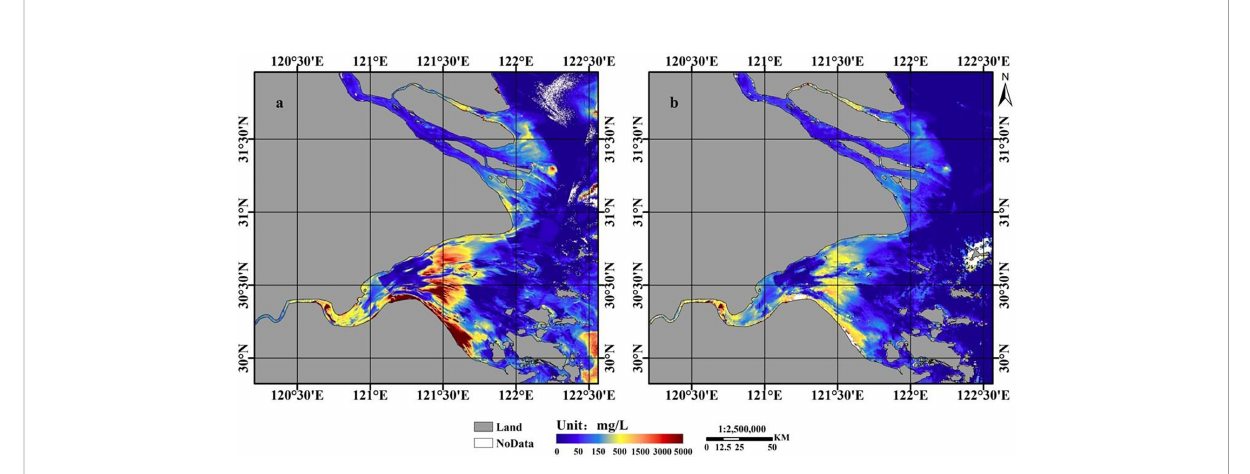
FIGURE 6 Retrieval results of SSC based on OLCI (A) and GOCI (B) data (July 23,